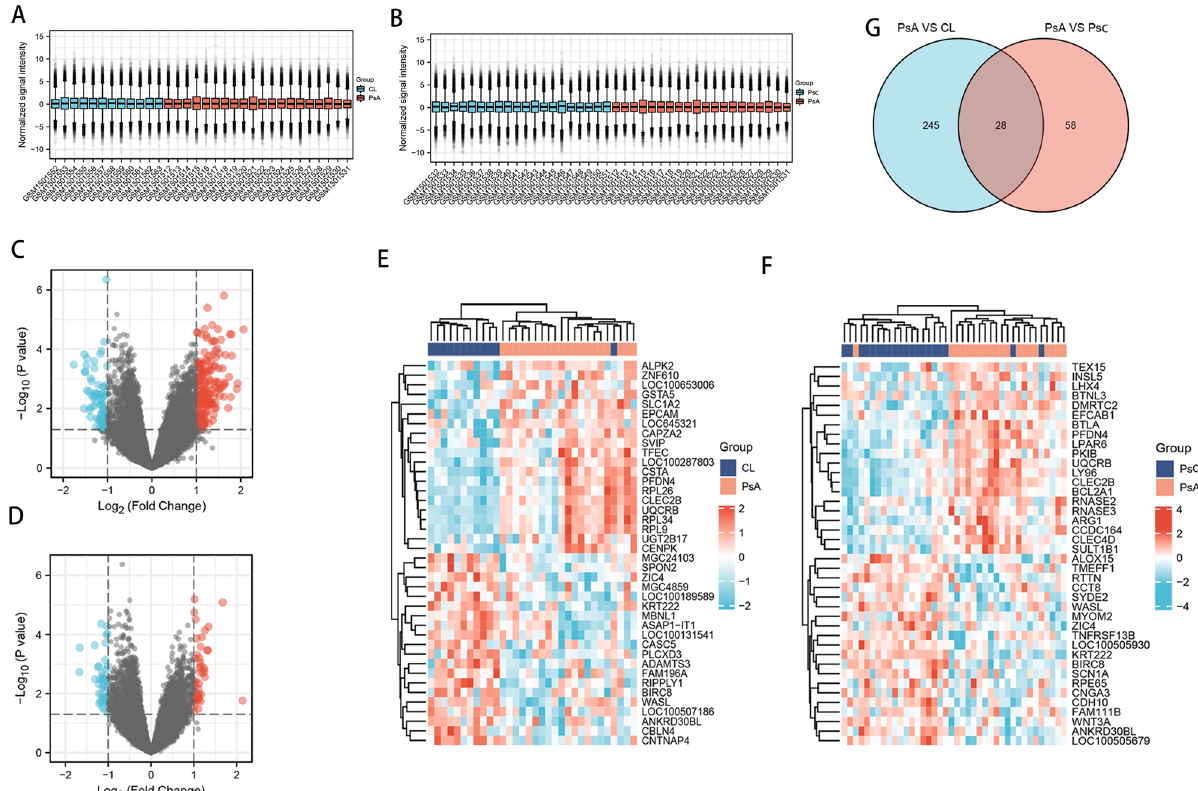
Figure 2. Identification of differentially expressed genes (DEGs). ( A ) Box plot after data standardization of PsA and CL group. ( B ) Box plot after data standardization of PsA and Ps group. Volcano plots of DEGS between the PsA and the CL ( C ) as well as PsA and PsC group ( D ). The red point in the plot represents the over-expressed mRNAs and the blue point indicates the down-expressed mRNAs with statistical significance. Heatmap of top 50 DEGs between PsA and CL group ( E ) and between the PsA and PsC group ( F ). ( G ) A Venn plot of DEGs overlapped between two